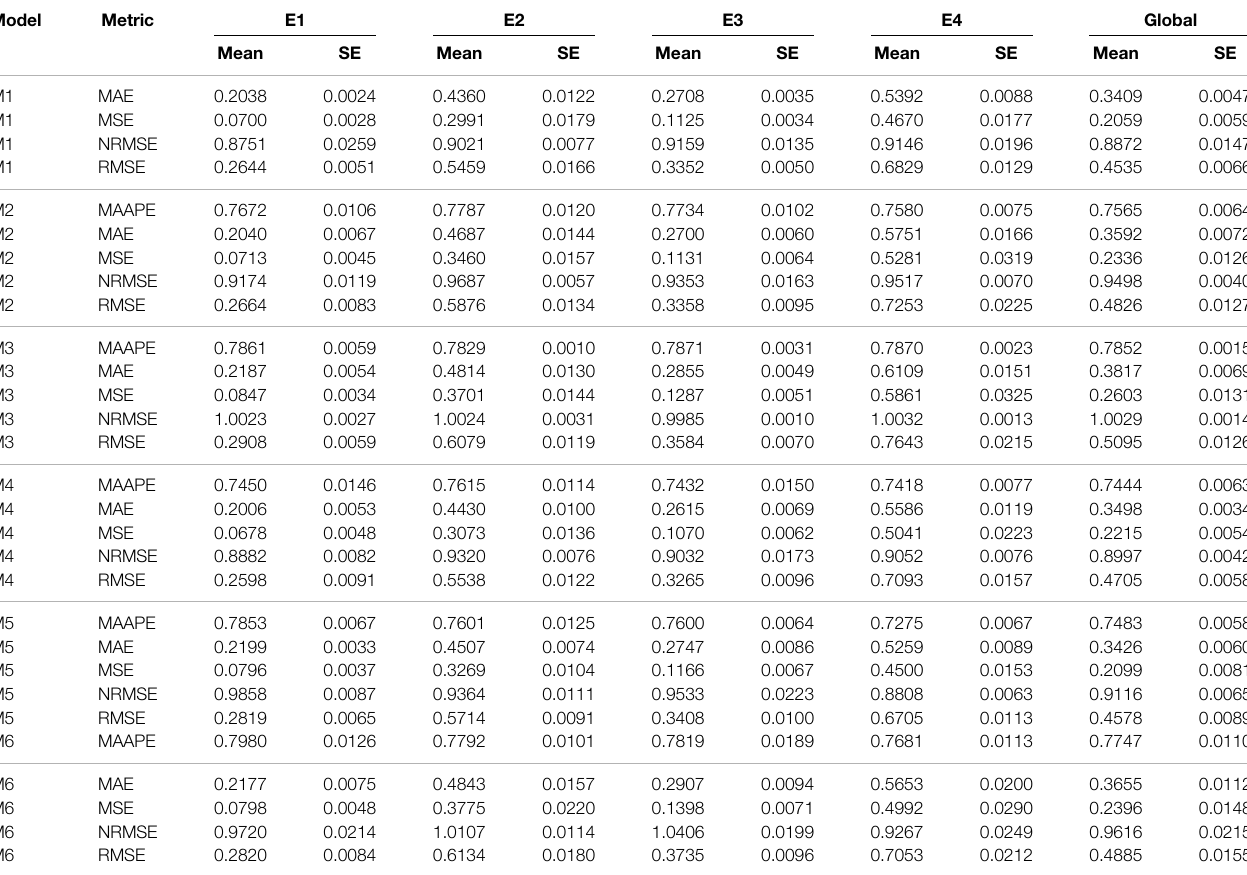
TABLE 3 | Prediction performance of the Maize data set for each environment and across environments (Global) of each of the six models.